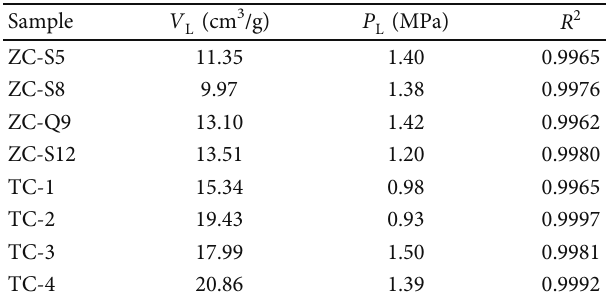
Table 4: Fitting results of adsorption parameters for the coal